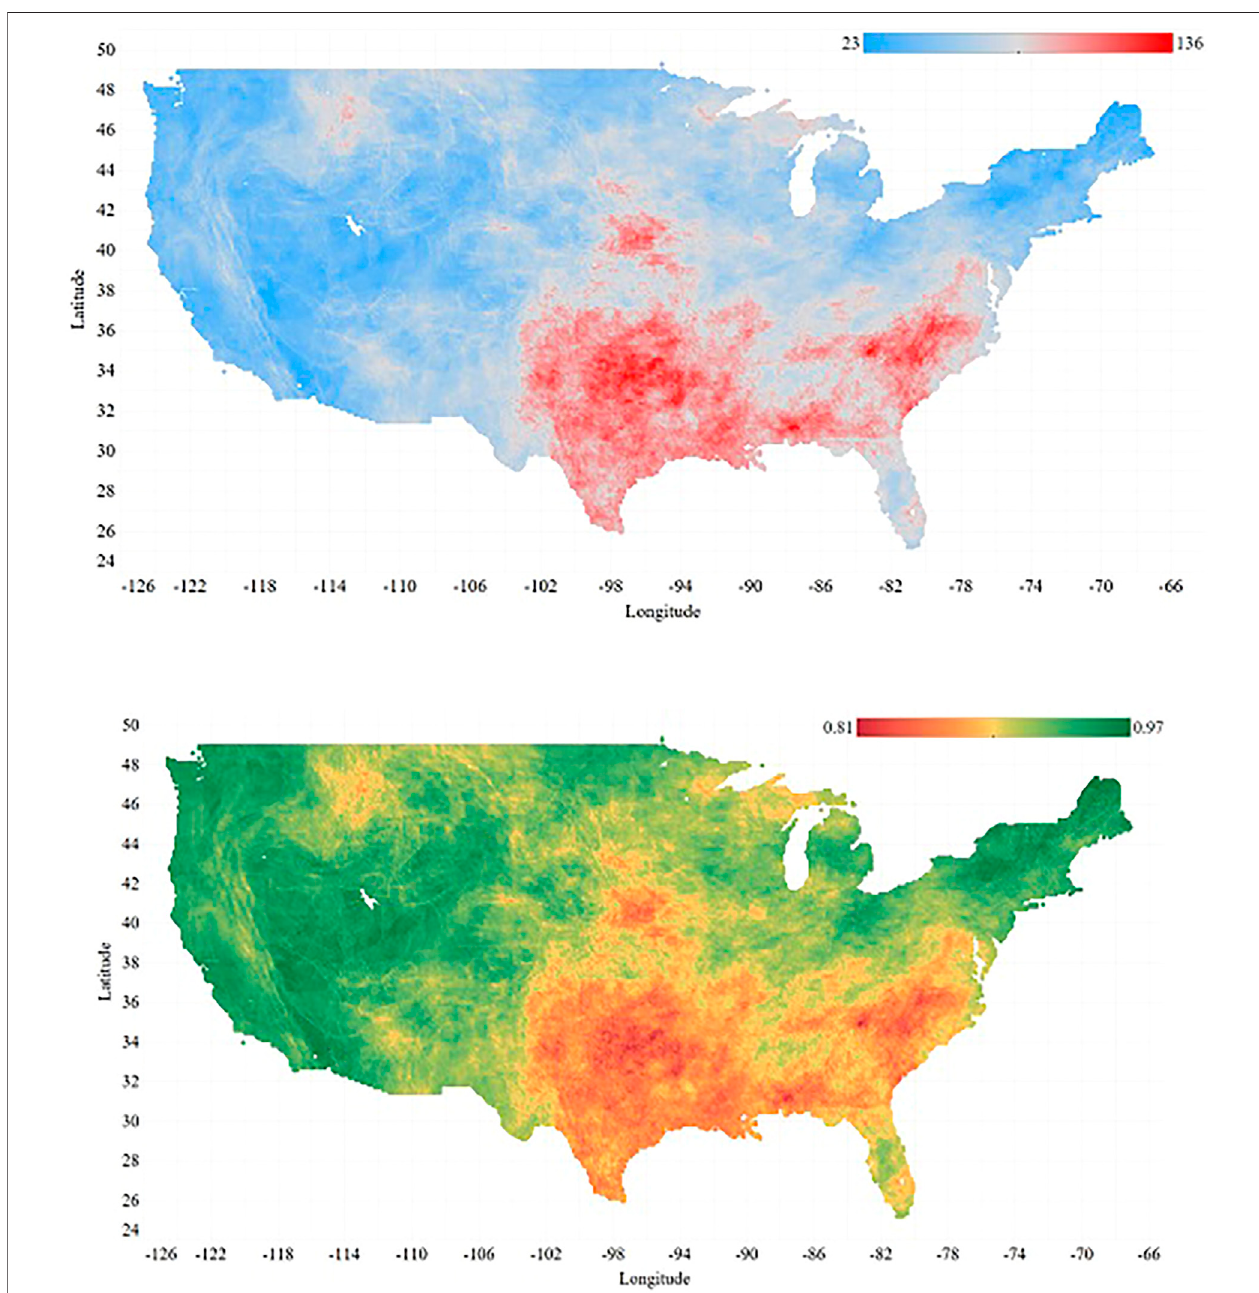
FIGURE4| UpperPanel:Spatialpresentationofthenumberofweekly fl uctuationsforeachgridcellduring731 weeks(thenumberofchangesindroughtcondition during 731 weeks) – Lower Panel: Spatial distribution of the persistence model weighted average F1 Score across the domain of study.